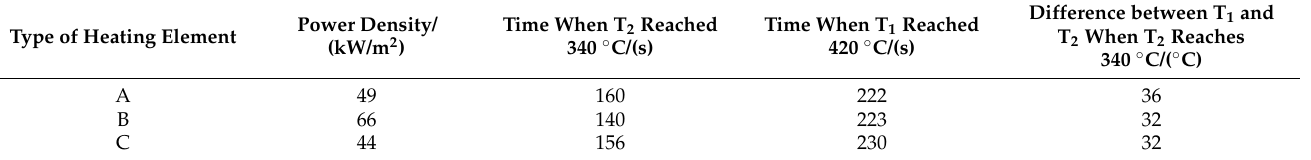
Table 5. Power density, welding time at specific temperatures and temperature differences at the joining interface obtained with different types of heating elements at similar heating rates.